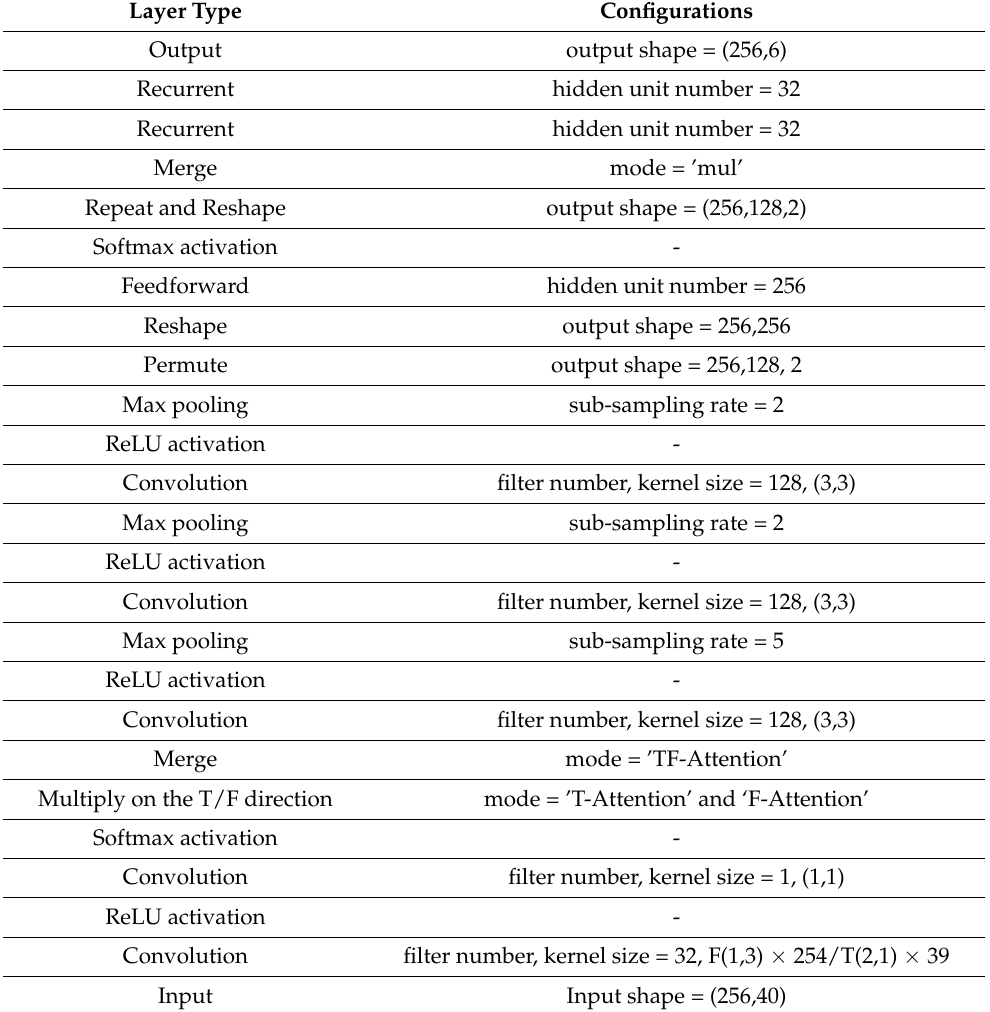
Table 2. The structure of the TFFS-CRNN model. The bottom is the input